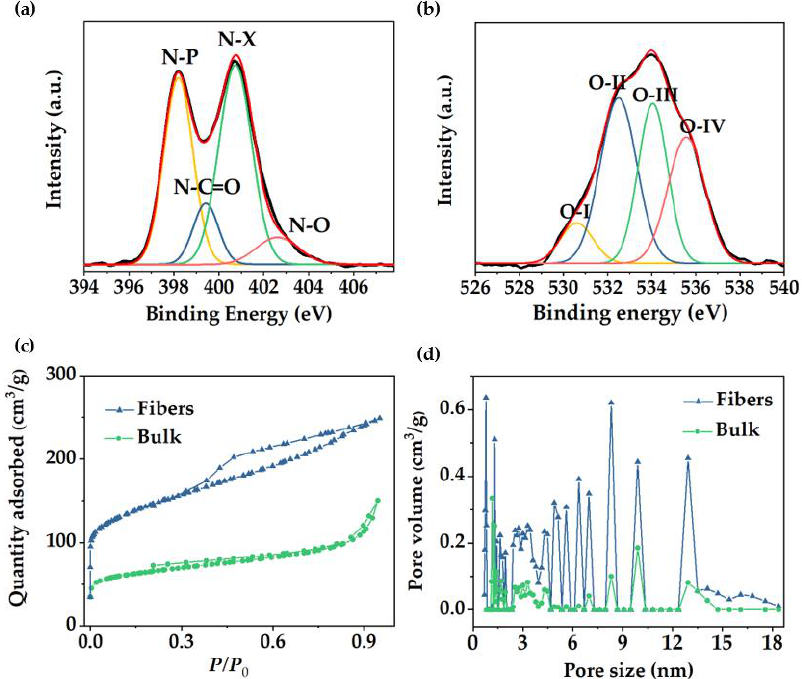
Figure 4. ( a , b ) XPS high resolution spectra of N and O, respectively, of the porous carbon fibers, ( c ) N 2 adsorption/desorption isotherms, and ( d ) NLDFT pore size distribution of fibers and bulk carbon material.